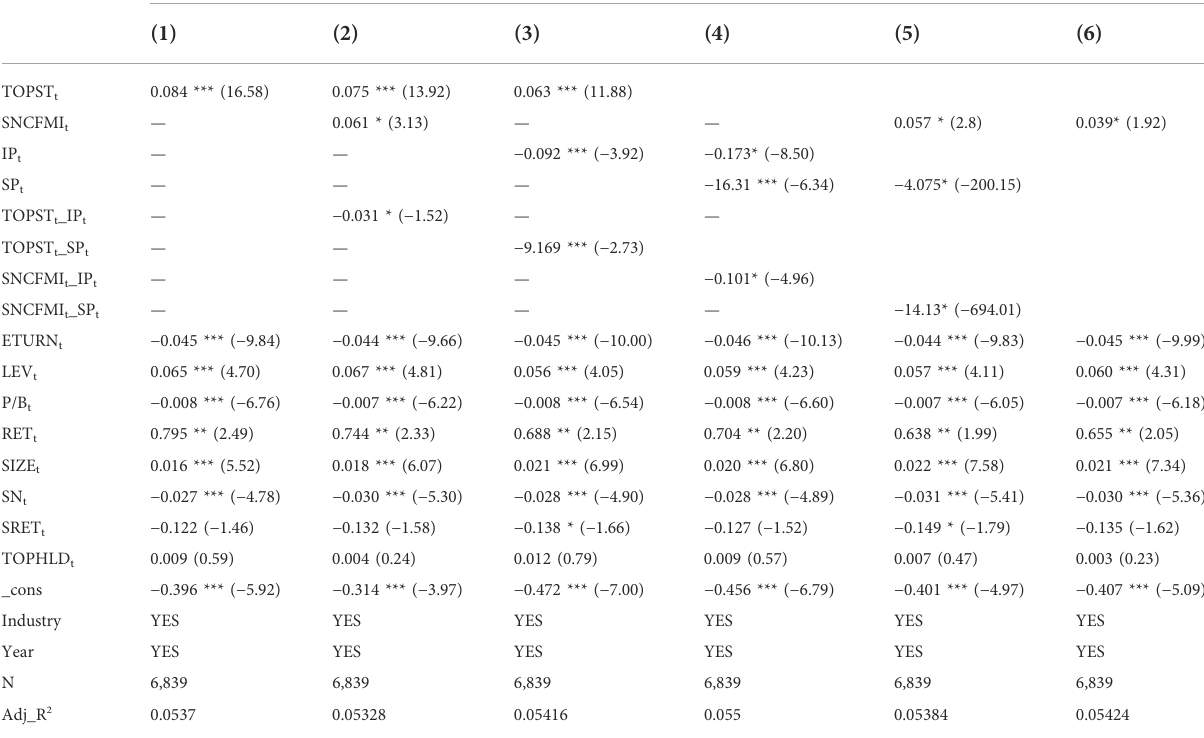
TABLE 2 Regression test results for hypotheses 1 and